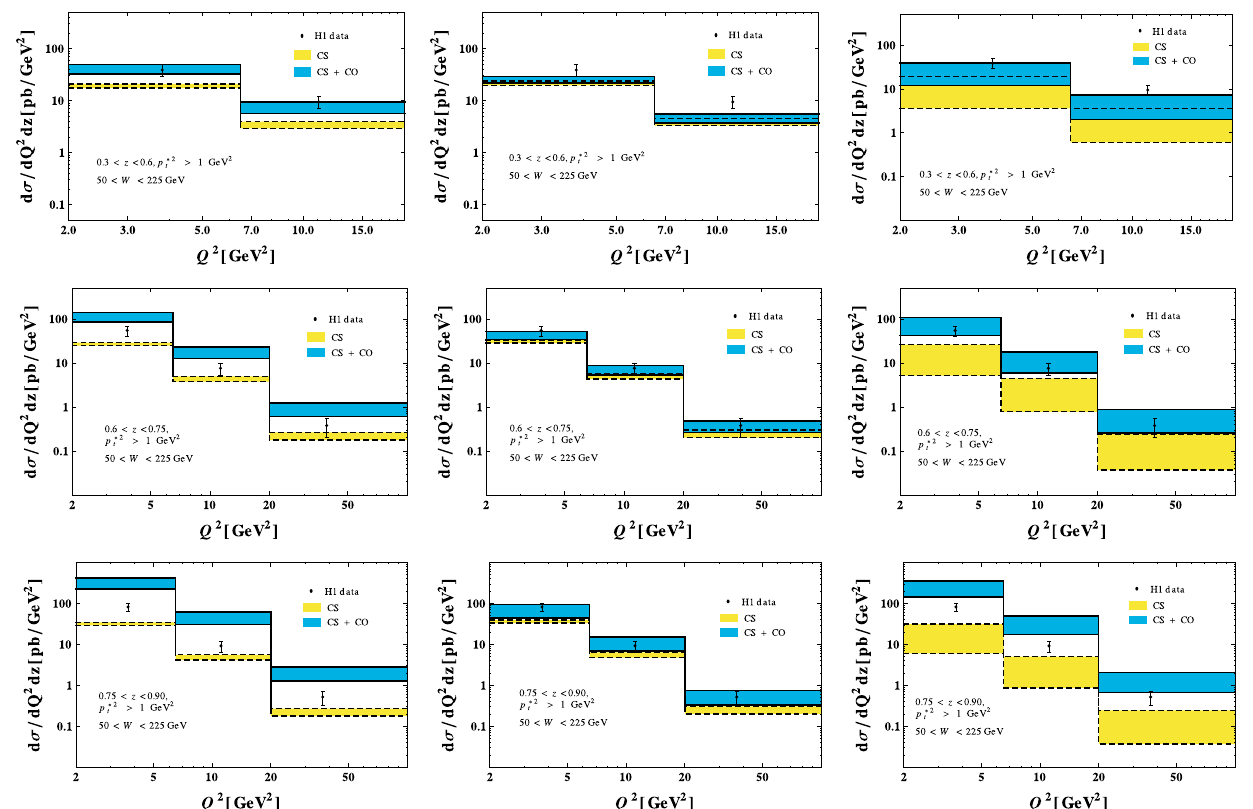
Fig. 18 The double differential cross sections for the J /ψ production in DIS with respect to Q 2 and z . The experimental data are taken from Ref. [49]. The l.h.s., middle, and r.h.s. plots correspond to the LDMEs taken in Refs. [28,30,41],